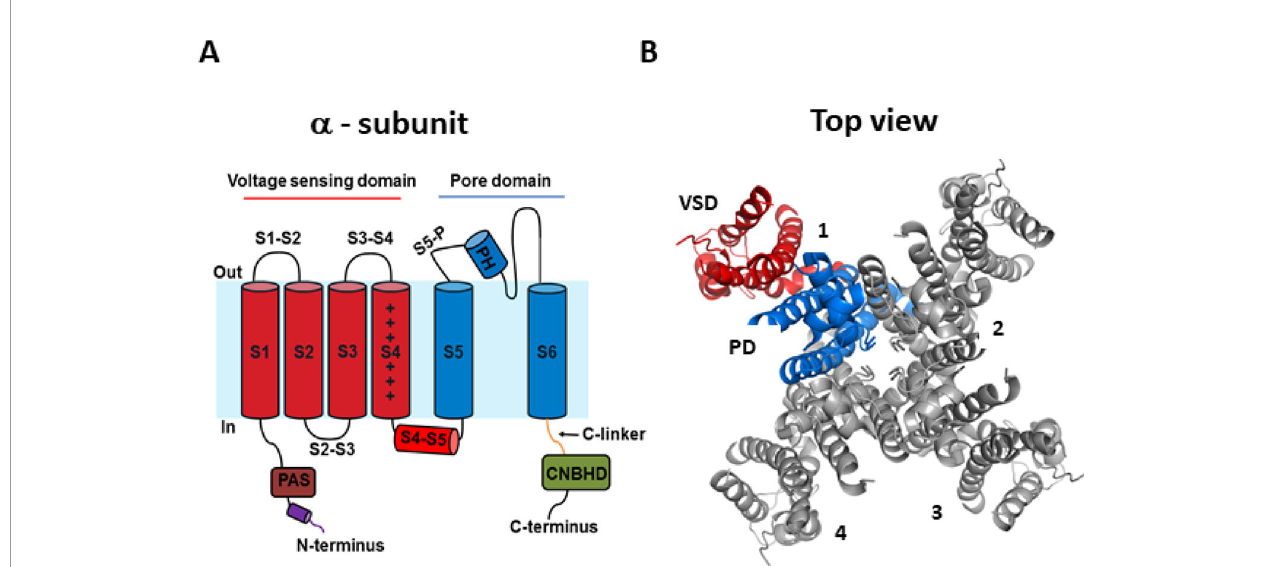
FIGURE 1 | hERG channel structure. (A) Schematic of a single a -subunit of the hERG channel comprising of six a -helical transmembrane segments (S1 – S6). The voltage sensing domain (VSD) (S1 – S4) and pore domain (PD) (S5 – S6) are highlighted in red and blue, respectively. Important features of the hERG channels include a short S4 – S5 linker, an intracellular N-terminus containing a PAS domain shown in brown, a cap region shown in purple, and the C-terminus containing a C-linker shown in green and a cNBHD domain shown in gray. (B) Top view of the cryogenic electron microscopy (cryo-EM) structure of the hERG channel assembled as a tetramer with the central conducting pore formed by pore domains from all four subunits. For clarity, only one subunit is highlighted (5VA1.pdb) (Wang and MacKinnon,